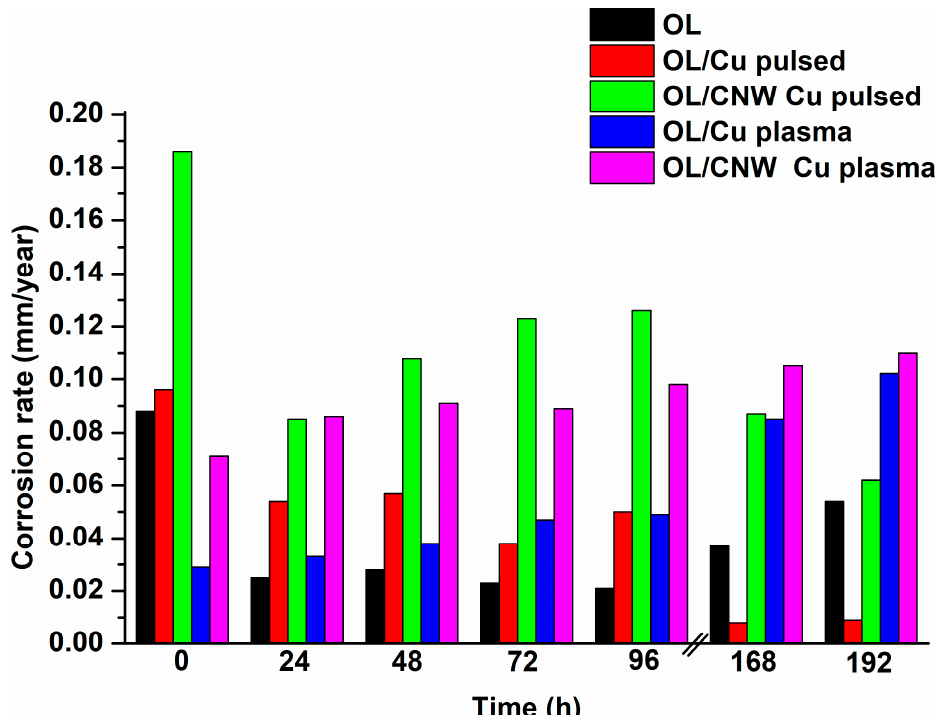
Figure 12. Corrosion rate in time for OL and all coated samples.